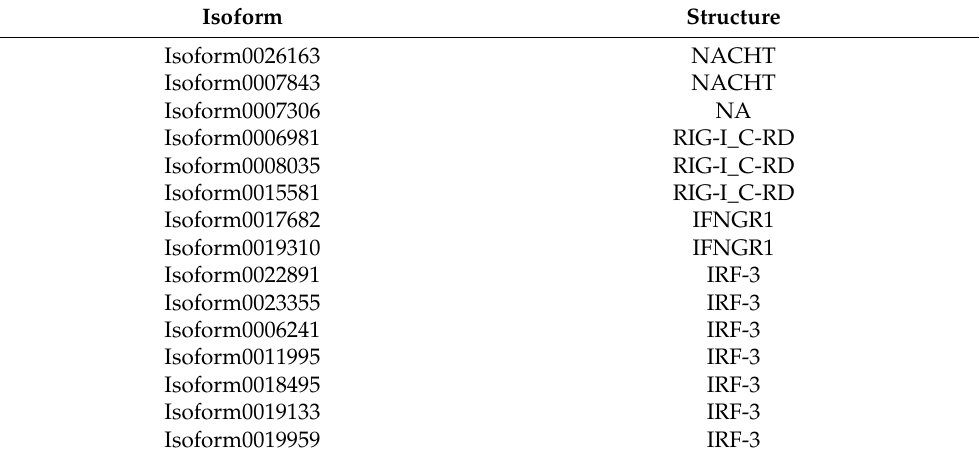
Table 2. NACHT, RIG-I, IFN, IRF-3, CD20, and TGF β domain containing proteins of the full-length transcriptome of M. pilosus